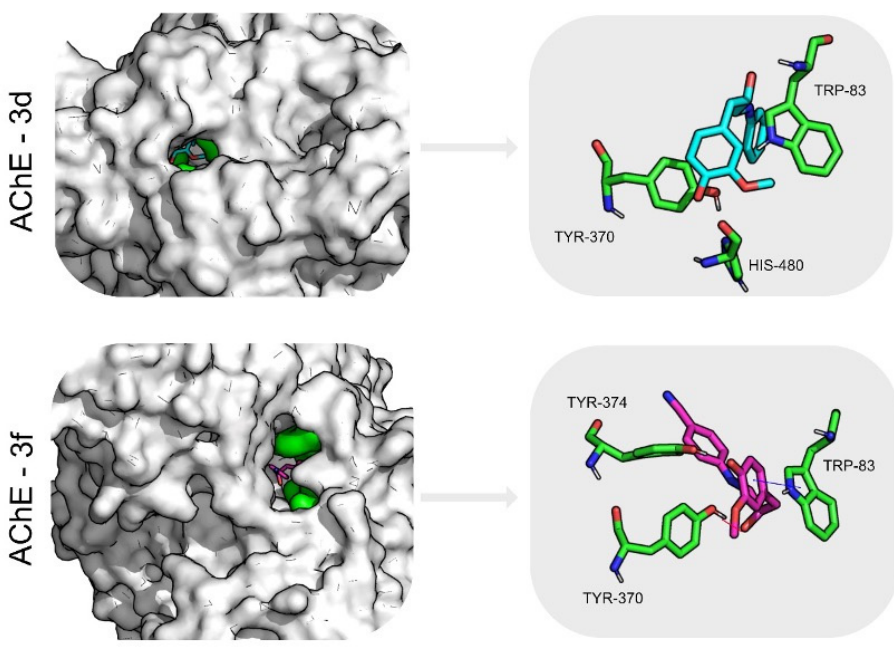
Figure 4. Compound 3d (cyan licorice) and compound 3f (pink licorice) interaction map with AChE. The most important residues for the interaction are highlighted in green. Blue arrow indicates π – π stacking with the ring of Trp-83. Red lines represent hydrogen bonding.